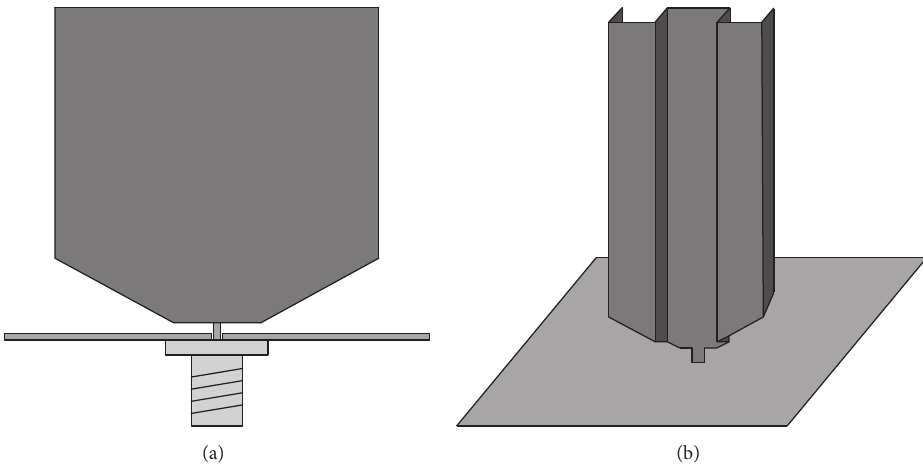
Figure 7: Hexagonal monopole antenna (a) and folded monopole antenna (b) for broadband and UWB applications [20]. The accordion version is adopted to reduce the transverse size of the monopole. Dark gray monopole and medium gray ground plane.